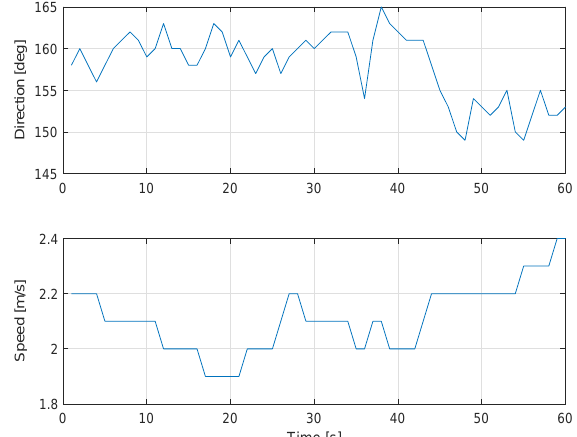
Figure 7: Actual wind speed and direction relative to north (0 degrees). The direction is to be in- terpreted as ”coming from